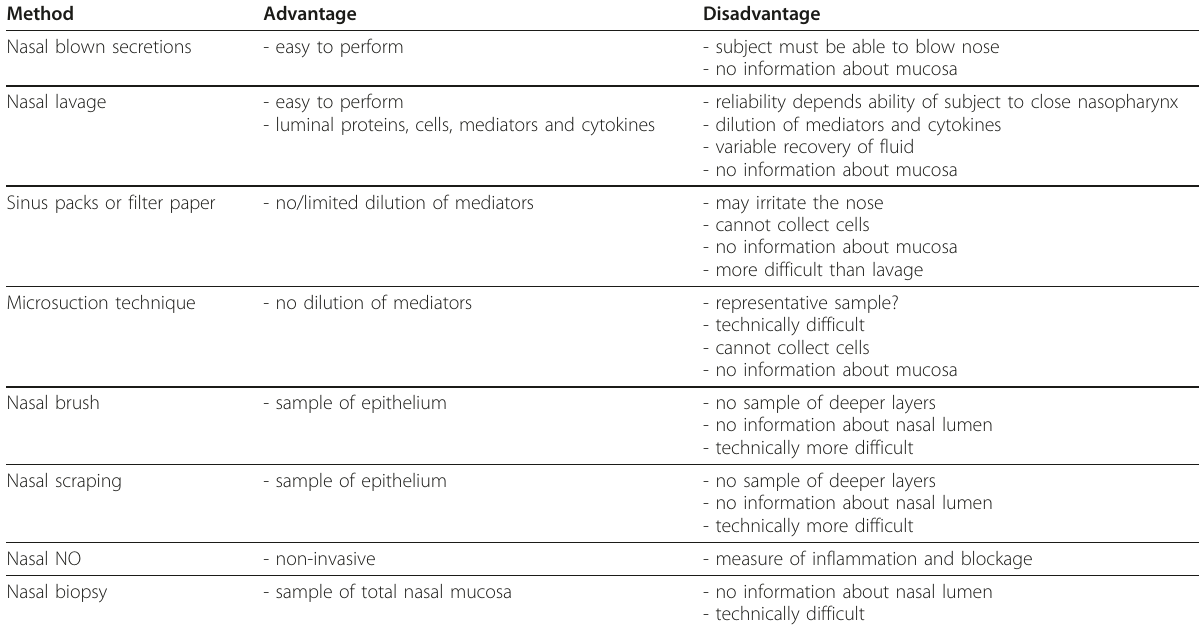
Table 5 Comparison of different techniques